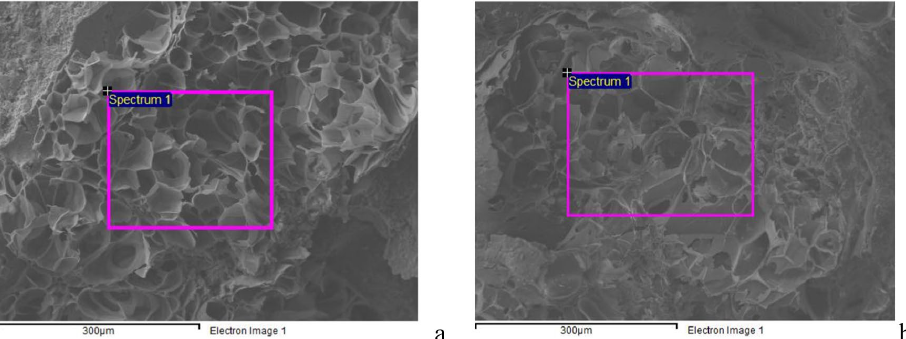
solution or coating for EDS analysis